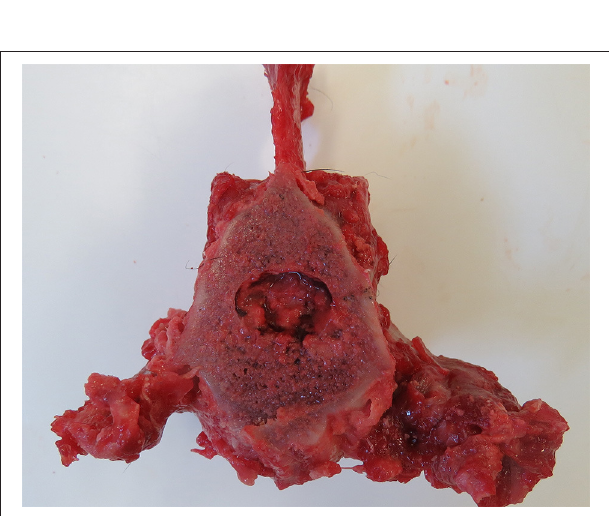
FIGURE 4 | Post-mortem specimen; transverse section at the level of mid-L5 vertebral body. Note the concentric narrowing of the vertebral canal, as well as the hyperostosis and smooth osseous proliferation of the articular surfaces. necroscopic findings were consistent with stage V multicentric lymphoma with concurrent vertebral hyperostosis. The cell size, lack of auxiliary plasma cells and amyloid production was consistent with T-cell differentiation, as suspected from the flow